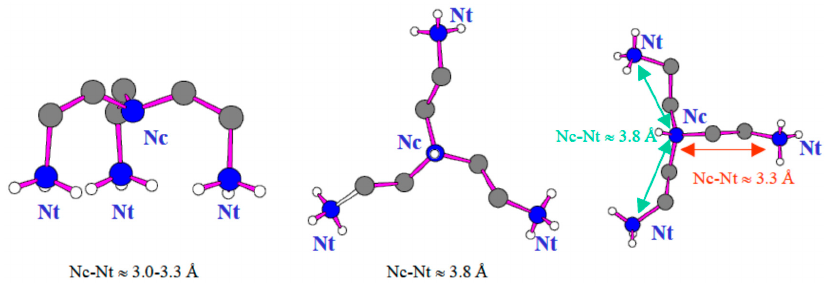
Figure 3. Configuration spider ( left ), plane ( middle ) and scorpion ( right ) of the tren amine.